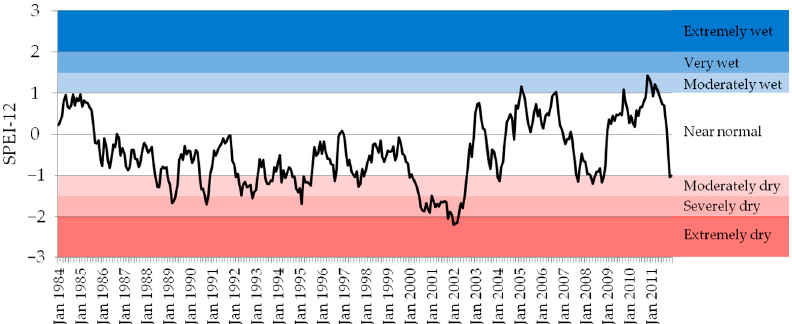
Figure 1. Time series (January 1984–December 2011) of the SPEI (at a time scale of 12 months) index, averaged over the Basilicata region (upper left: 41.25, 16.75; down right: 39.75, 15.25), from Global Drought Monitor [41]. SPEI categories from [20].